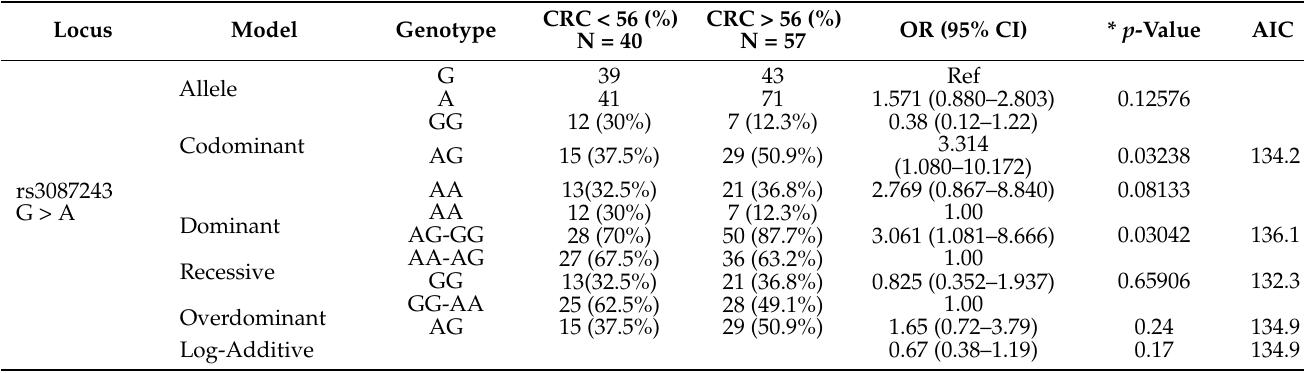
Table 5. Association of CTLA-4 with colorectal cancer cases after gender stratification. CRC,